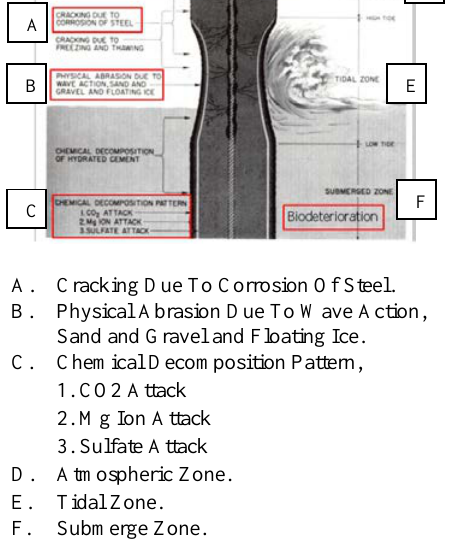
Figure 1. Typical degradation mechanisms in coastal concrete piling. (Source: Holland, 2012).